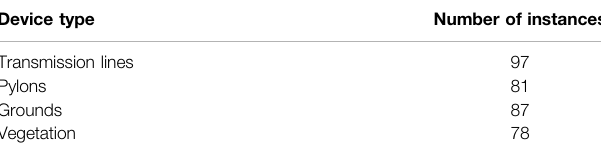
TABLE 2 | Distribution of transmission line point cloud data set.